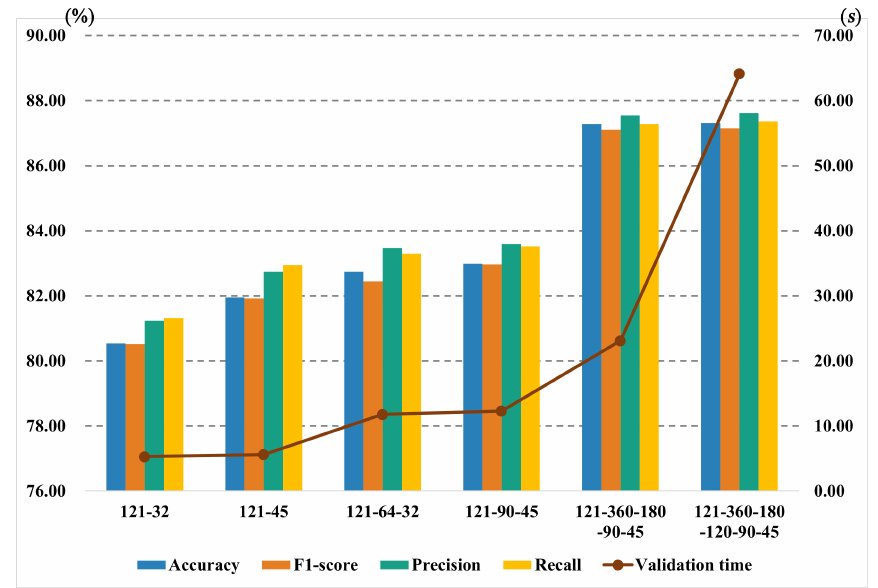
Figure 7. Effect of different LCVAE structures on detection